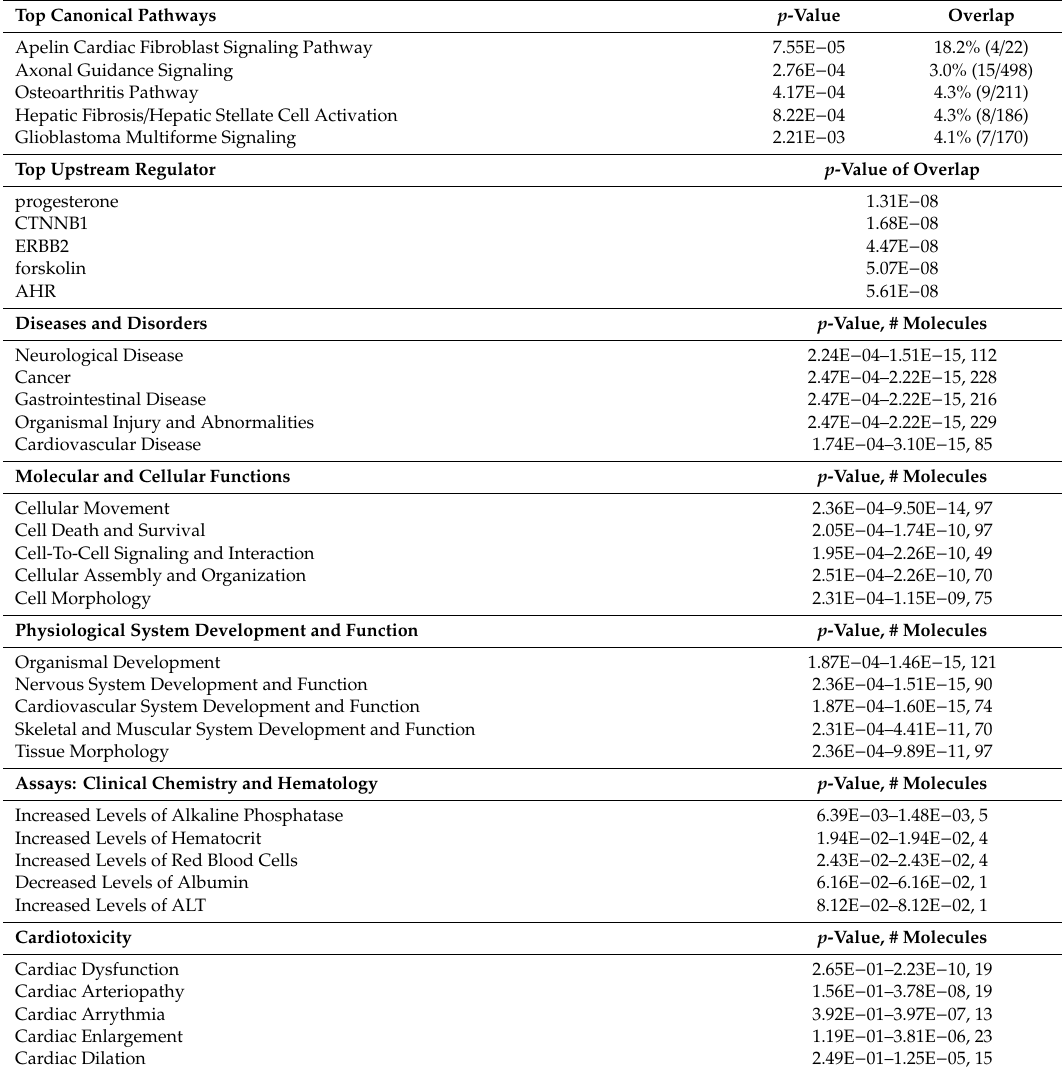
Table 2. Predicted di ff erential pathways generated by the Ingenuity Pathway Analysis Software (IPA) for meningioma tumors with high AGR2 expression compared with tumors with low AGR2 expression. Top Canonical Pathways p -Value Overlap Apelin Cardiac Fibroblast Signaling